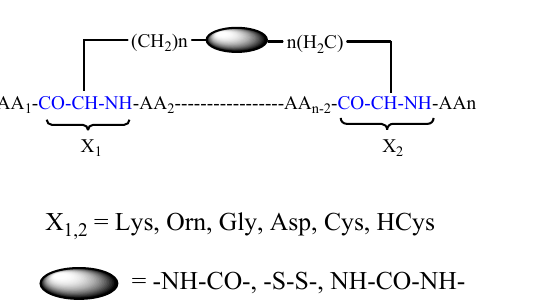
Figure 2. Schematic representation of peptide optimization methodologies.